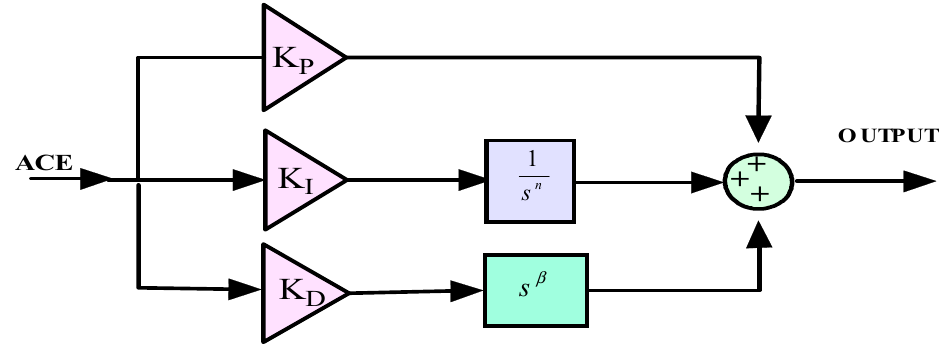
Figure 6. Fractional order PID controller.